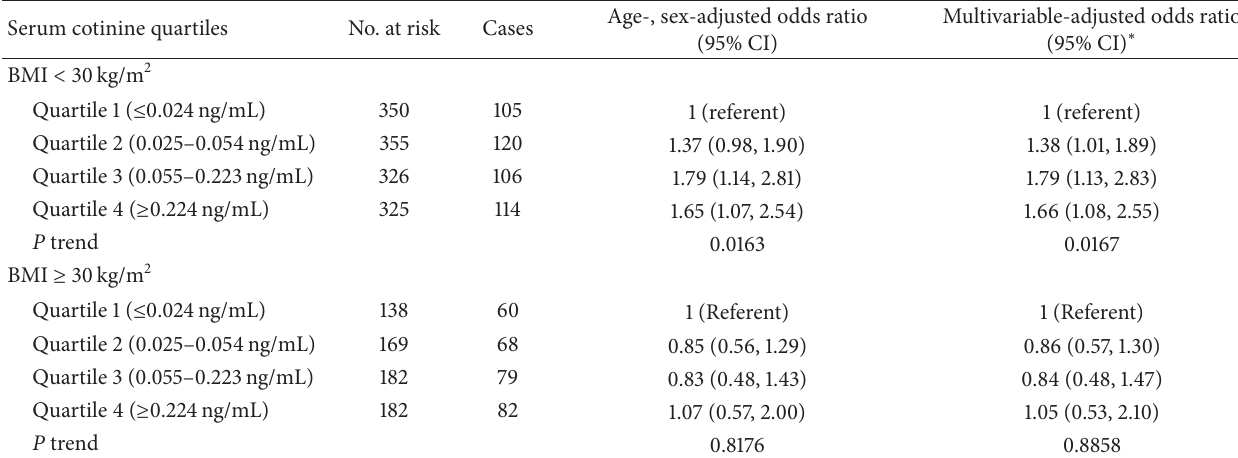
Table 5: Association between serum cotinine levels and prehypertension by body mass index. Serum cotinine